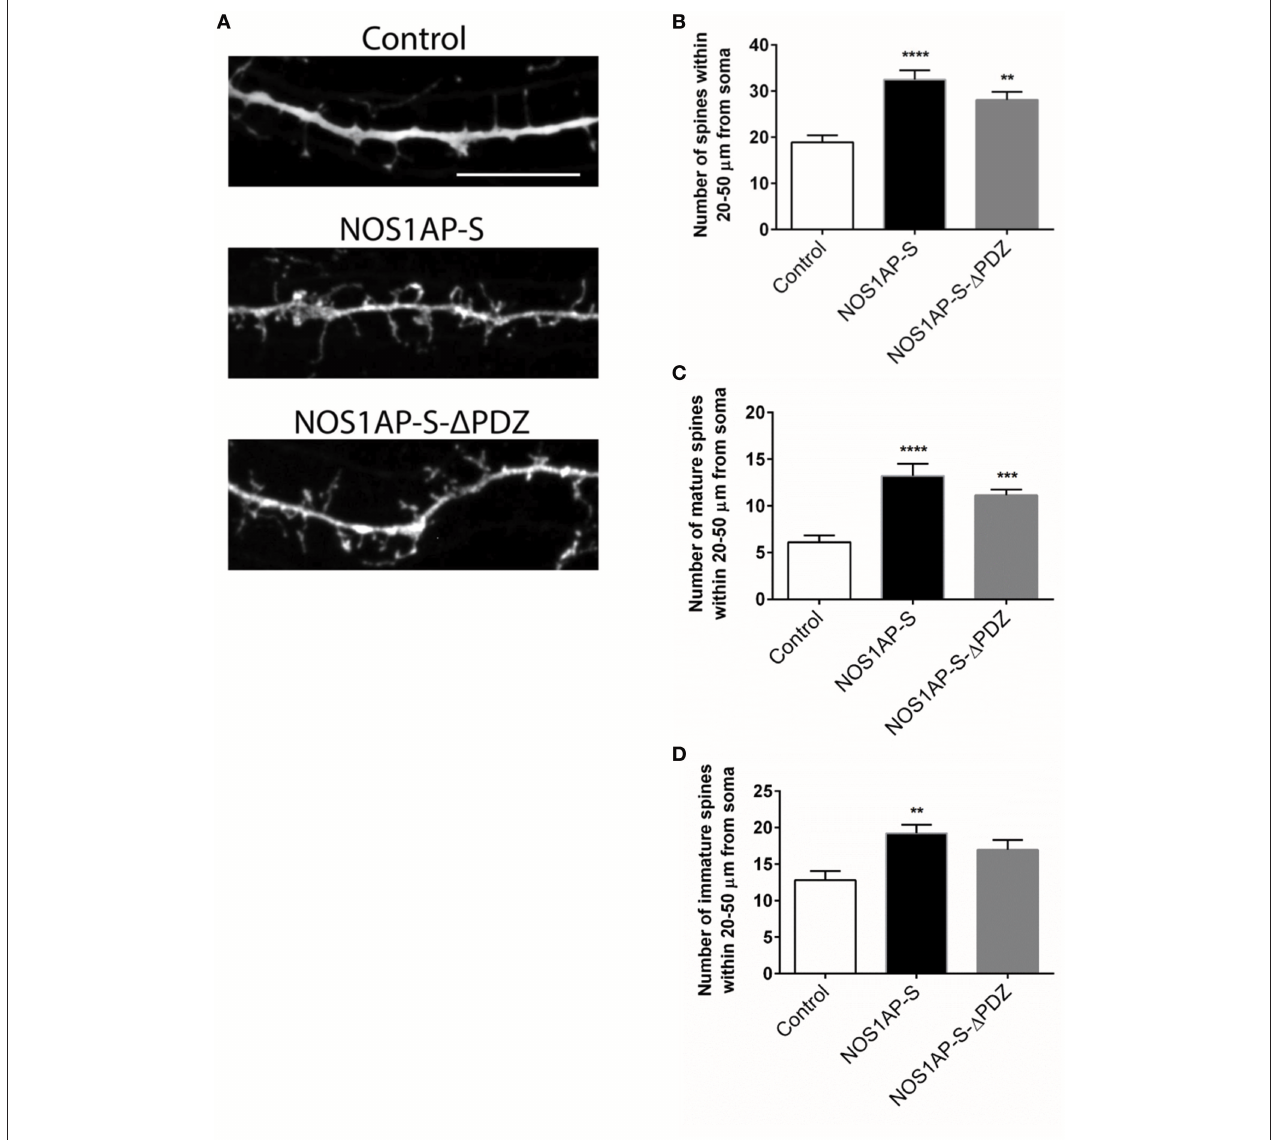
FIGURE 6 | NOS1AP-S alter spine number and morphology. (A) Representative images of dendrites from rat cortical neurons (DIV 17) transfected with pCAG-GFP (control), pCAG-GFP-NOS1AP-S, or pCAG-GFP-NOS1AP-S- 1 PDZ. Scale bar = 10 µ m. (B) , Number of spines per 30 µ m segment in cultured neurons expressing indicated proteins. ** p < 0.01 and **** p < 0.0001 vs. GFP. p -values were determined by one-way ANOVA followed by Bonferroni Multiple Comparisons test. Error bars indicate ± s.e.m. (C) Number of mature spines per 30 µ m segment in cultured neurons expressing indicated proteins. *** p < 0.001 and **** p < 0.0001 vs. GFP. p -values were determined by one-way ANOVA followed by Bonferroni Multiple Comparisons test. Error bars indicate ± s.e.m. (D) Number of immature spines per 30 µ m segment in cultured neurons expressing indicated proteins. ** p < 0.01 vs. Control. p -values were determined by one-way